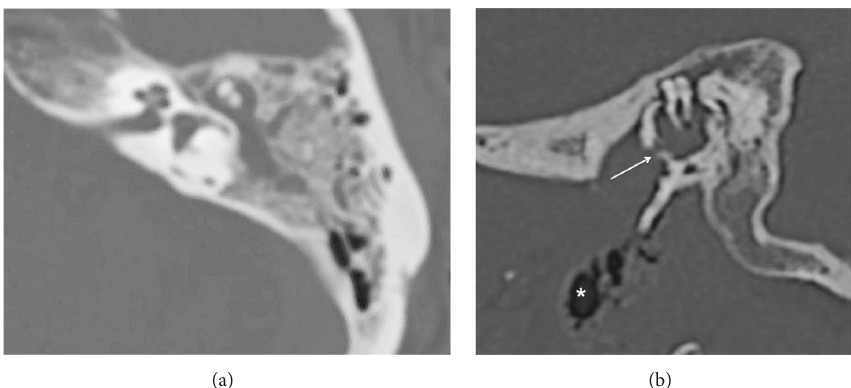
Figure 1: (a) Mastoiditis on the left side. There is diffuse debris throughout the mastoid. (b) An erosion of the anterior-inferior wall of the middle ear cavity (arrow) with air bubbles in the left prestyloid compartment